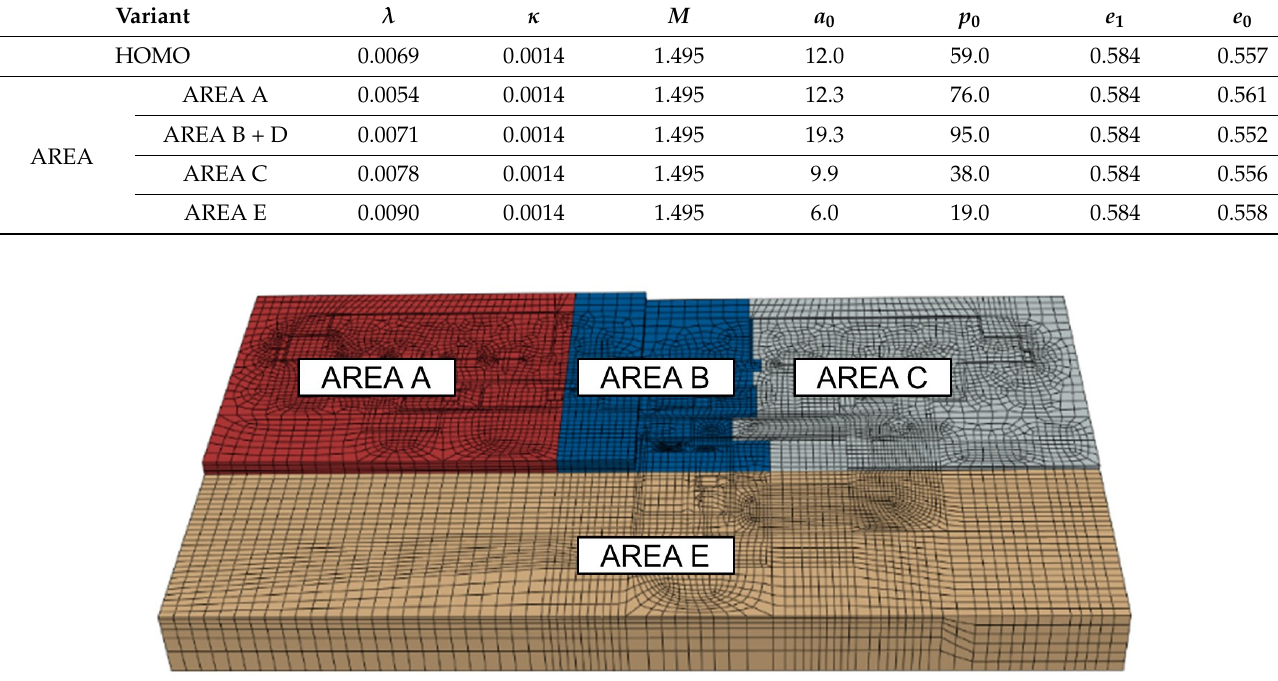
Figure 14. The division of the subsoil into computational areas.